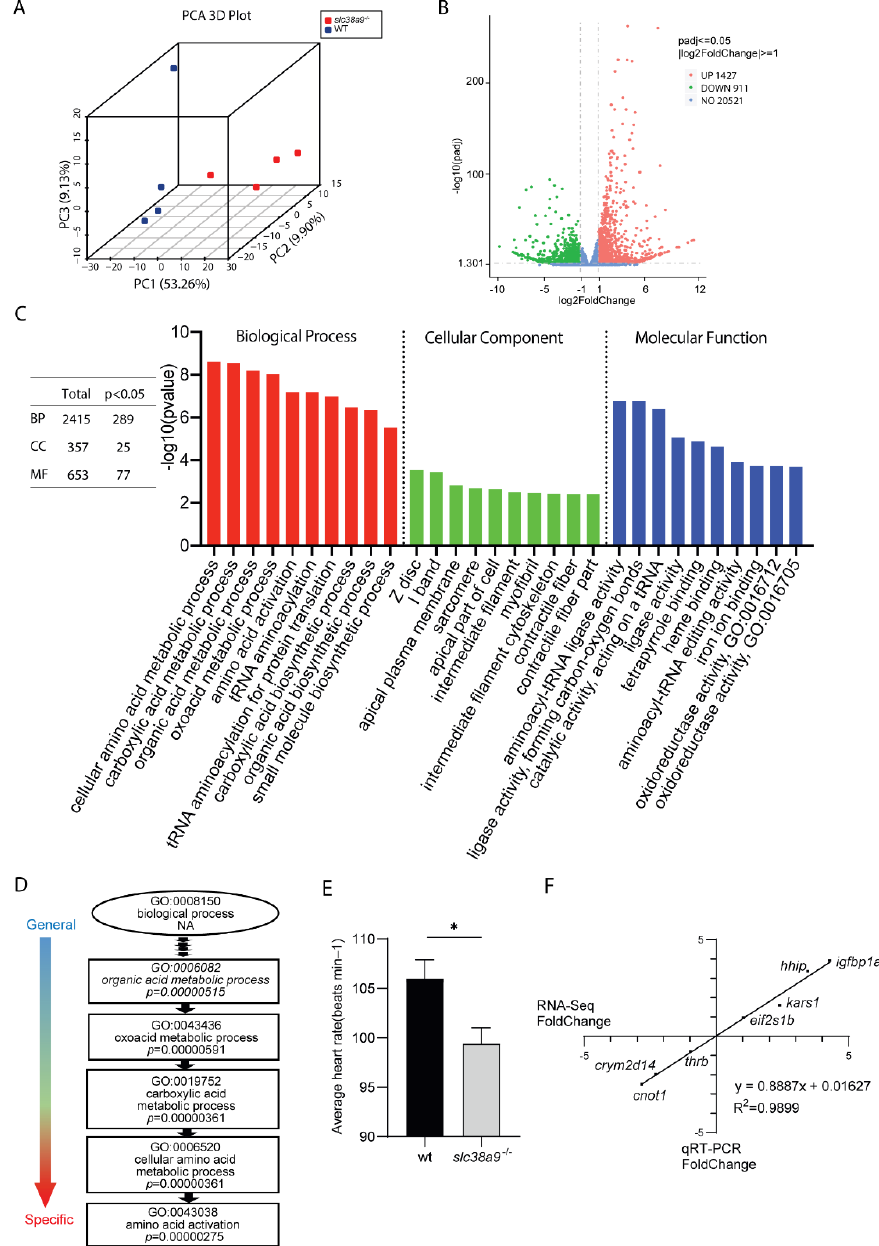
Figure 3. RNA sequencing analysis of slc38a9 mutant zebrafish. ( A ) Principal component analysis (PCA) plot of four wild type and slc38a9 mutant RNA-seq datasets. Principal component 1 (PC1), principal component 2 (PC2), and principal component 3 (PC3) were used for analysis. ( B ) Volcano plot of differential expression analysis of slc38a9 mutant and control larvae showing the relationship between − log10(padj) and log2FoldChanges. The red dot shows upregulated genes, the green dot shows downregulated genes, and the blue dot shows an unchanged gene. ( C ) Gene ontology (GO) analysis of differentially expressed genes in biological processes (red column), cellular component (green column), and molecular function (blue column). ( D ) The directed acyclic graph (DAG) of biological process. The lower terms are more specific, while the upper terms are more general. ( E ) Average heart rate of 60 hpf WT and slc38a9 mutant zebrafish larvae. Data shown are mean ± SEM, n = 10. * p < 0.05. ( F ) Correlation between qRT-PCR and RNA-seq results for select DEGs. The fold change values derived from the RNA-seq analysis of DEGs are compared with those obtained by qRT-PCR determined by 2 −ΔΔCT . The reference line indicates the expected linear relationship.